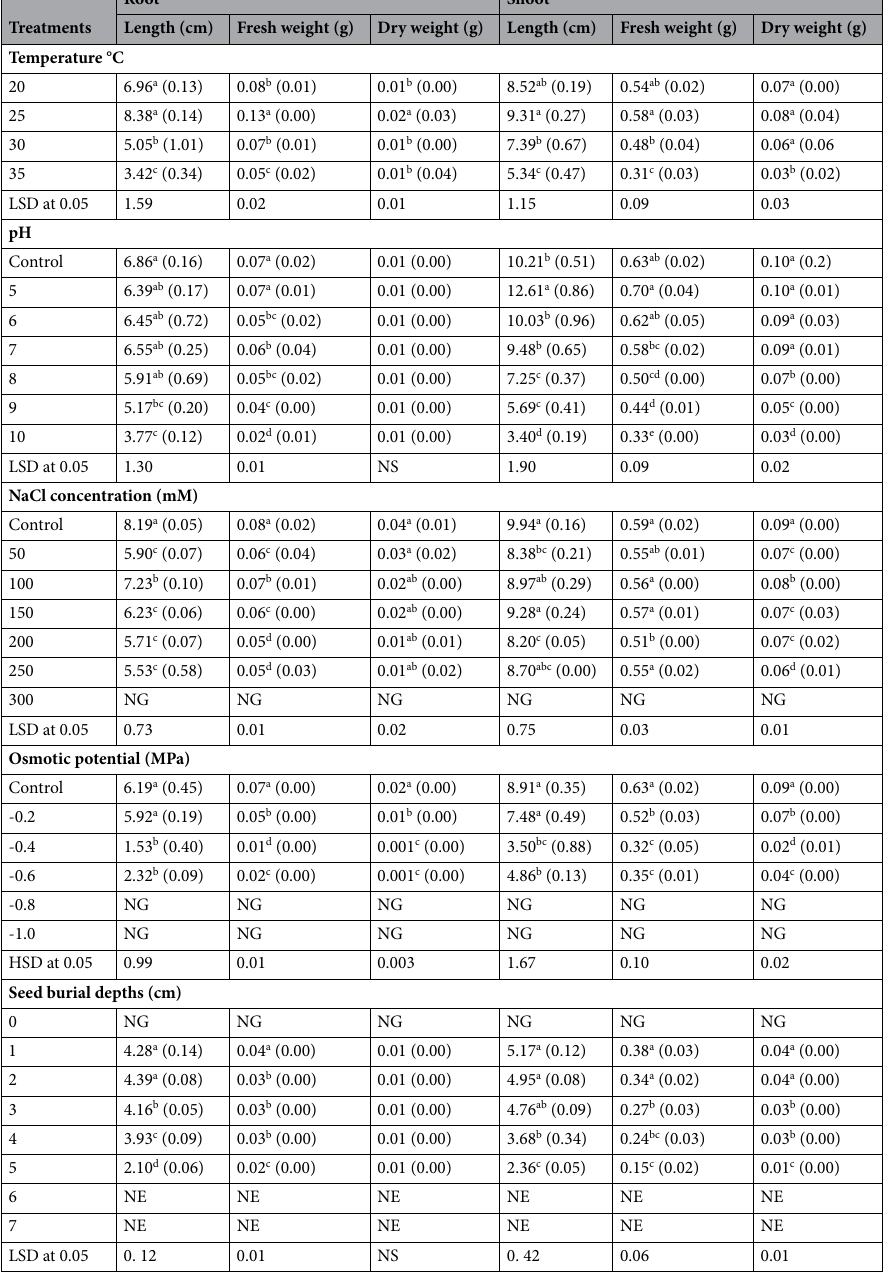
Table 2. Effect of temperature, pH, NaCl concentration, osmotic potential and seed burial depths on seedling growth of perennial ryegrass. NG or NE, no germination or emergence. The values within the column followed by different letters were significantly different at P ≤ 0.05. LSD = Least significant difference. Values in parentheses are standard errors of the